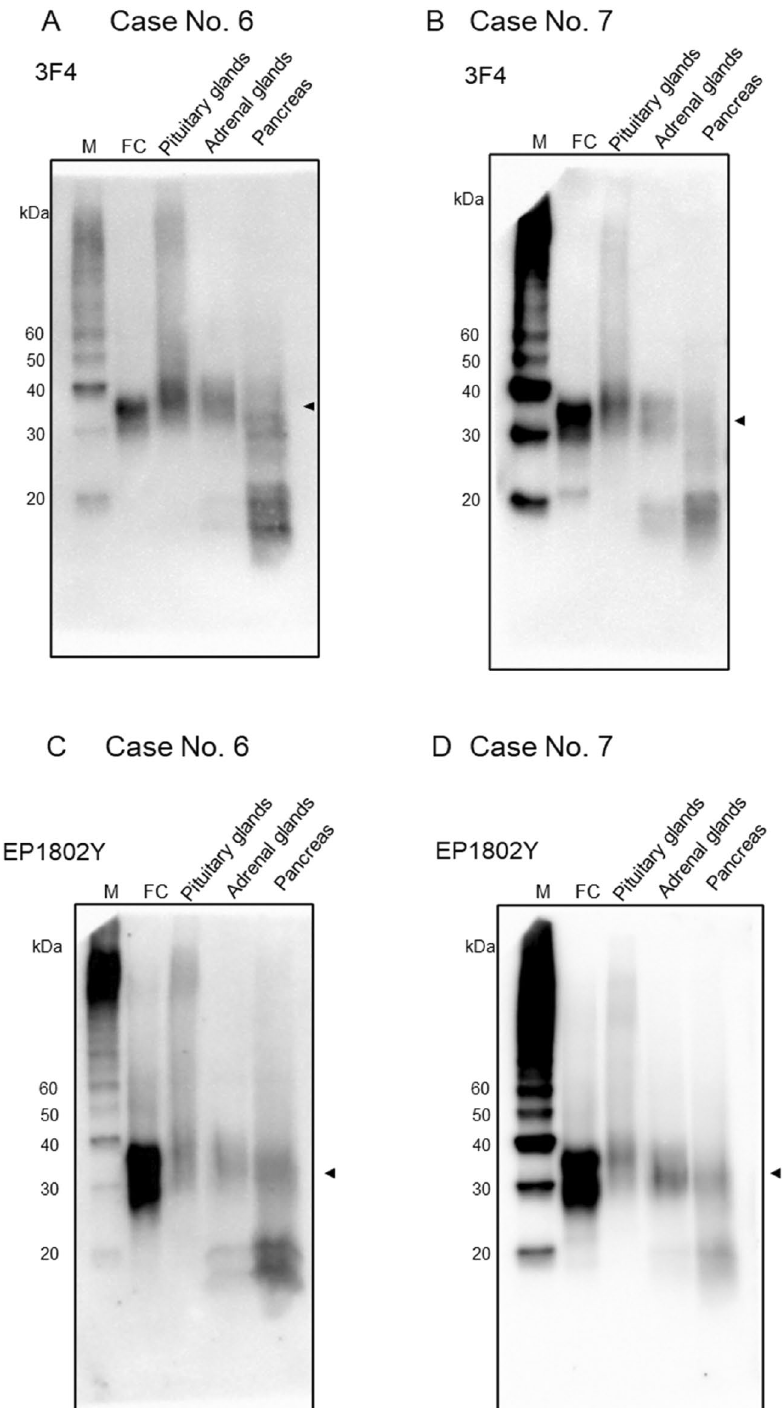
Figure 2. Western blot analyses from FFPE samples with the 3F4 ( A , B ) and EP1802Y ( C , D ) anti-prion protein (PrP) antibodies (case 6 and 7). ( A ) Case 6 ( B ) Case 7: Western blot analysis using 3F4, the frontal cortex (FC) samples show ~ 25–38 kDa PrP signals. The pituitary glands, adrenal glands and pancreas show ~ 30–40 kDa PrP signals (arrowhead). ( C ) Case 6 ( D ) Case 7: Western blot analysis using EP1802Y, the frontal cortex (FC) samples show ~ 25–38 kDa PrP signals. The pituitary glands, adrenal glands and pancreas show ~ 30–40 kDa PrP signals